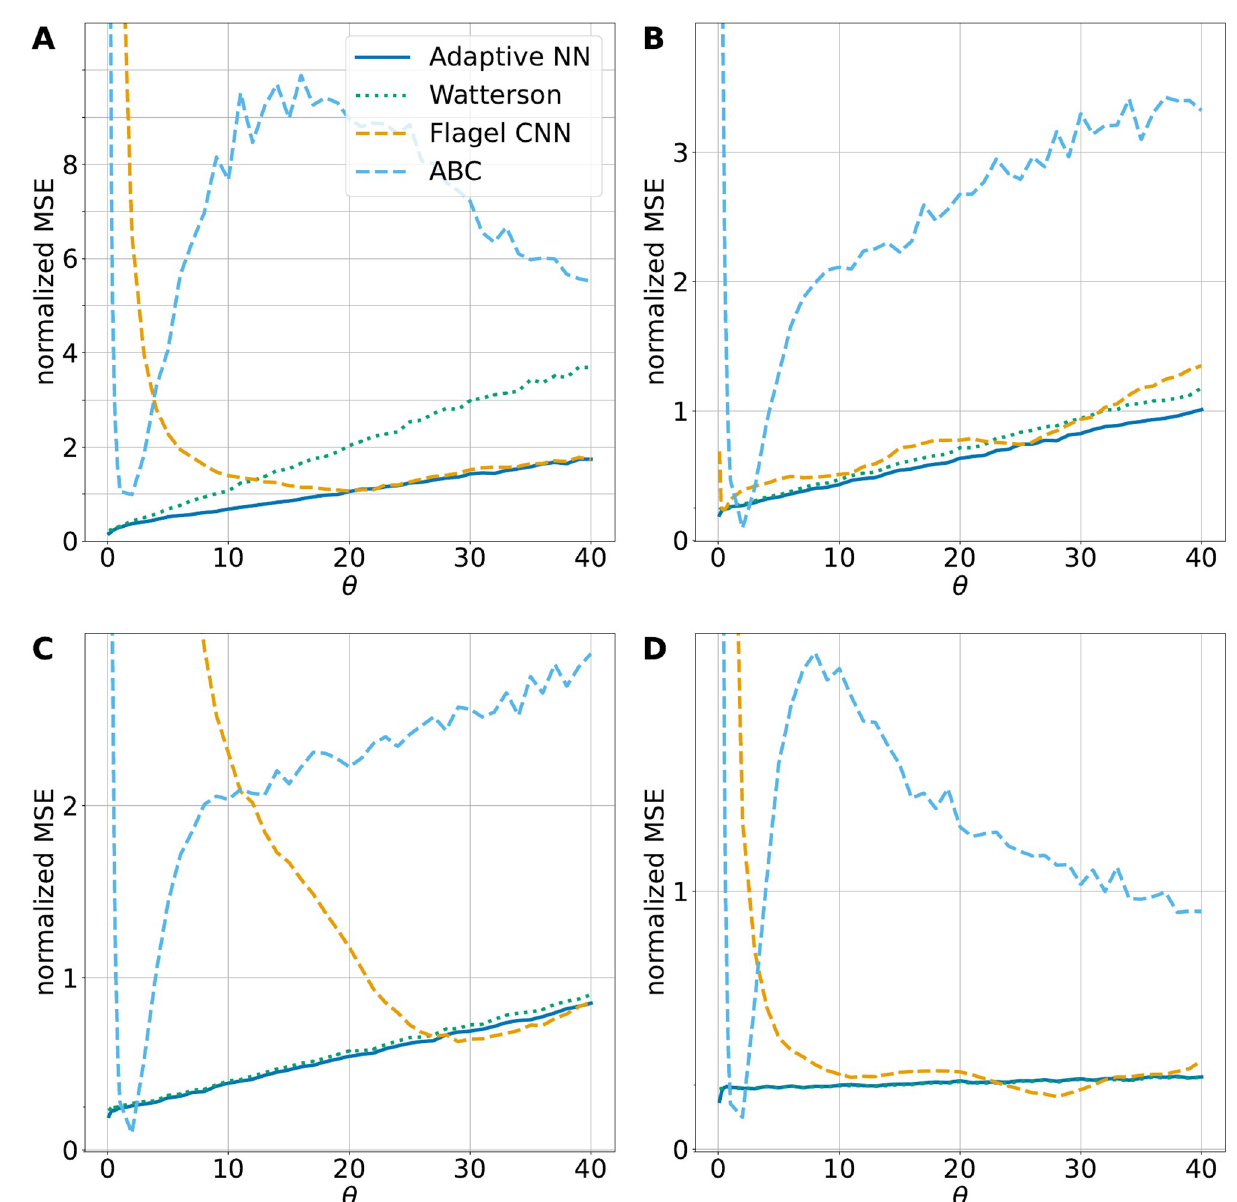
Fig 3. Comparison to other ML methods. The normalized MSE for four different estimators are shown: Watterson’s estimator and the adaptive neural network (as in Fig 1), a retrained CNN by Flagel et al. [21] and Approximate Bayesian Computation (ABC). The same simulations as in Fig 1 have been used. A: recombination rate ρ = 0, B: ρ = 20, C: ρ = 35, D: ρ = 1000. All shown neural networks and ABC have been trained on data sets with the corresponding recombination rate ρ